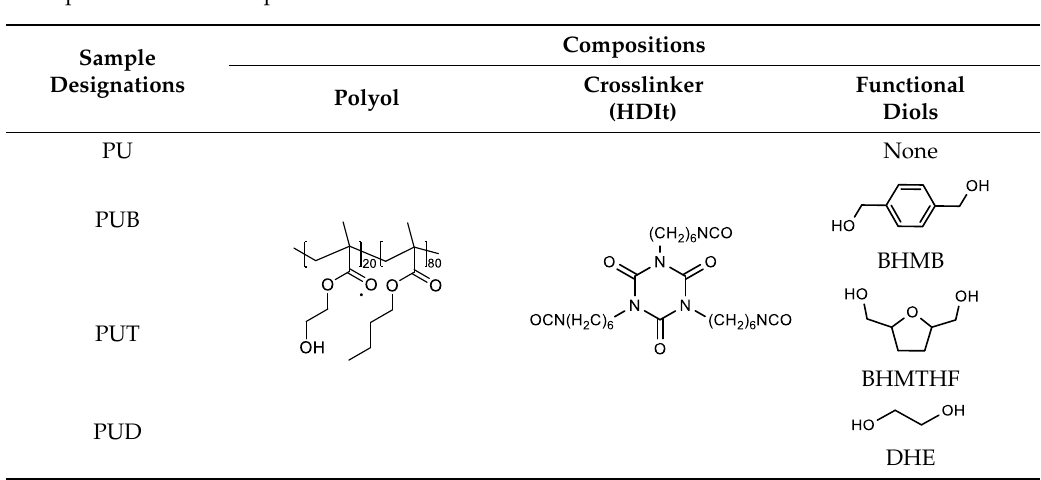
Table 1. Chemical structures of polyol, crosslinker, and functional diols and the designations and compositions of the samples.